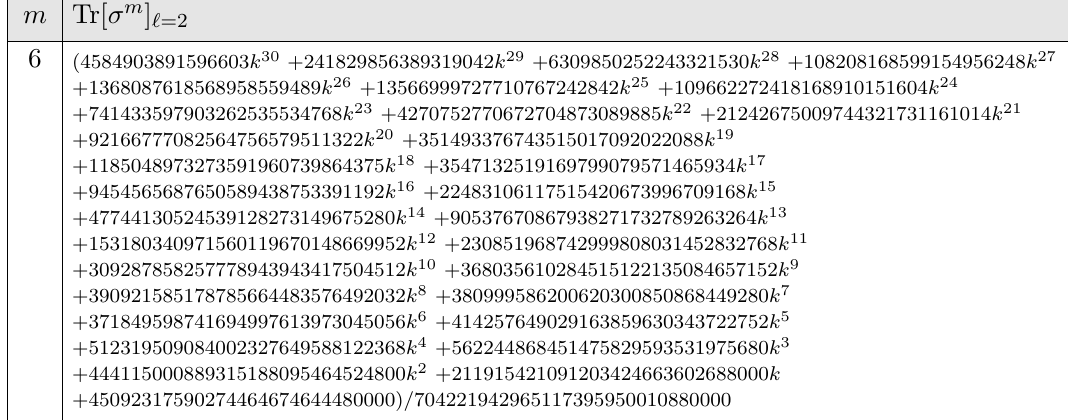
Table 7. The values of Tr [ σ m ] as a function of k for T 3 , 9 torus link. The subscript ‘ indicates that the polynomial is valid for k ≡ ‘ ( mod 3)